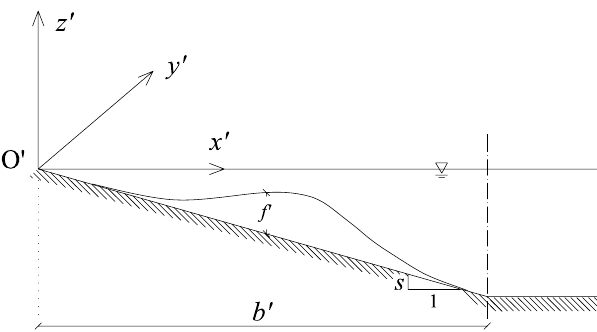
Fig. 10. Branch cuts in the complex plane for β(k,ω) Eq. (55). The complex frequency ω ∈ (cid:127) , which is the unshaded area corre- sponding to the lower half-plane, real axis included. Angles θ 1 and θ 2 are measured counterclockwise from the real axis on the chosen Riemann sheet Eq.